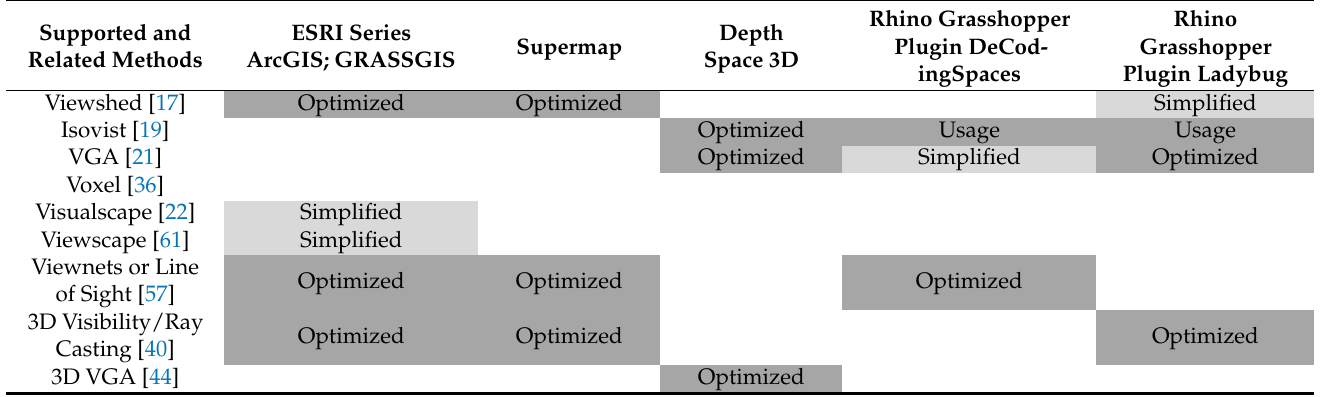
Table 2. Theoretical support for each tool. The color highlight can better illustrate the performance level, with light grey is mediocre, dark grey is good, and white is